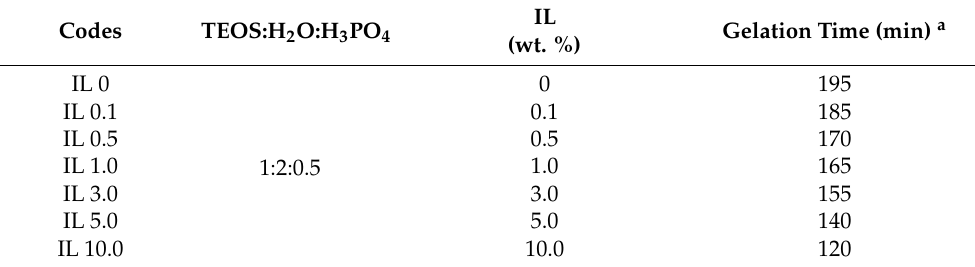
Table 1. Formulations of the sol–gel-based silica ionogels.